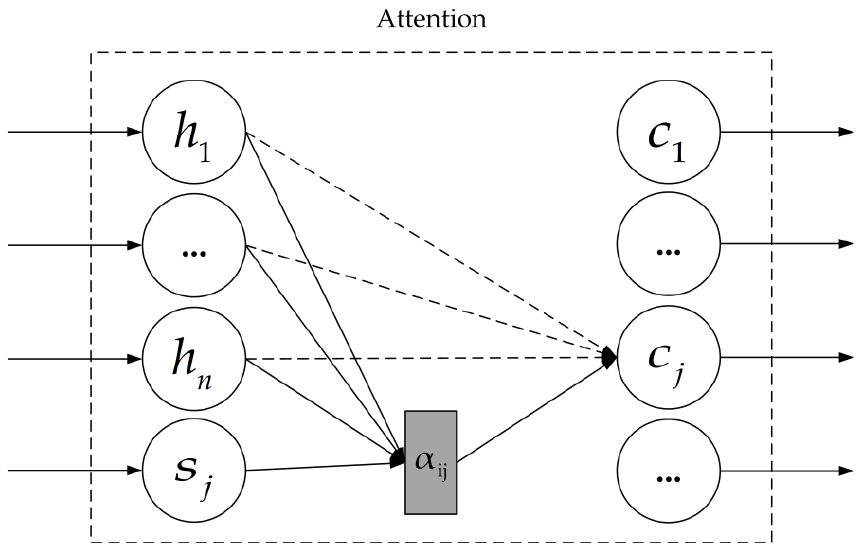
Figure 6. The structure of the Attention mechanism.